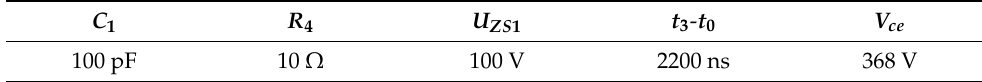
Table 3. Influence of R 4 on the turn off characteristics.